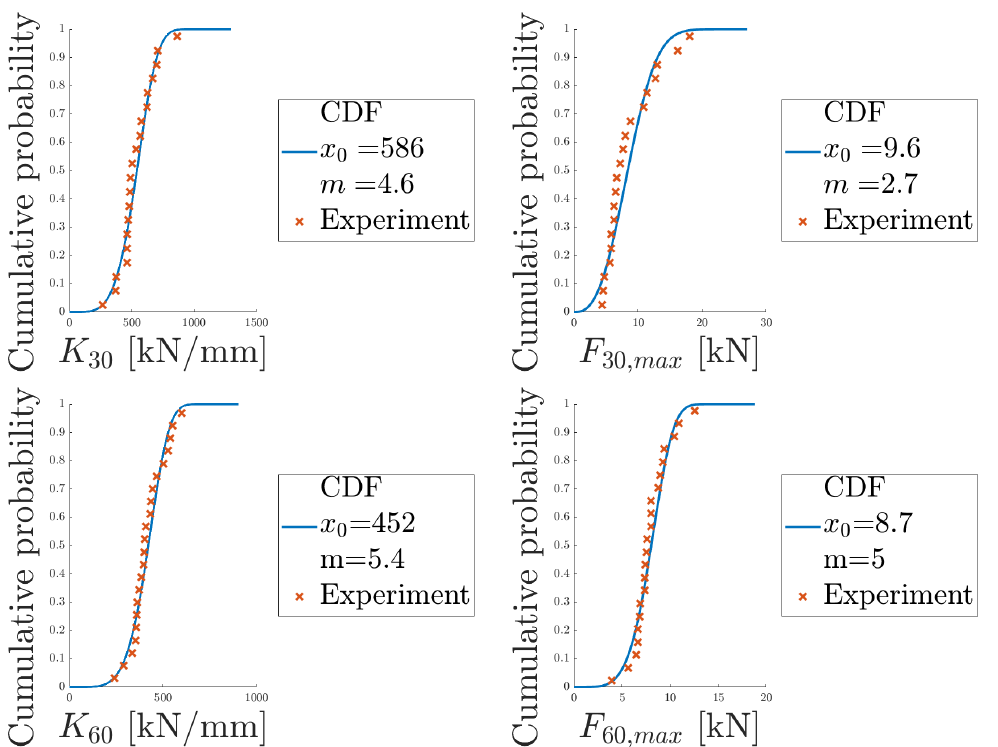
Figure 23. Cumulative density functions, obtained from the determined Weibull parameters, are presented for each parameter in Table 4.